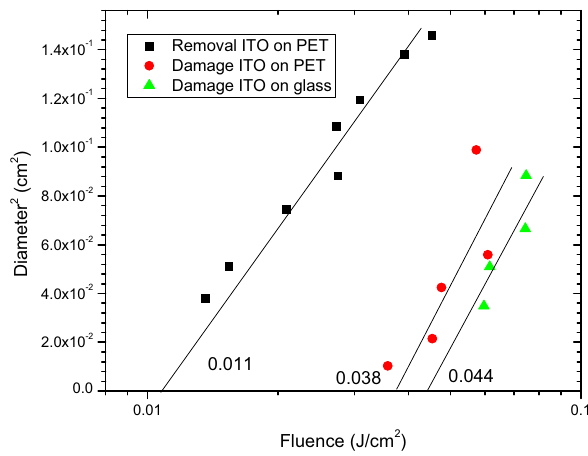
Figure 3: The threshold fl uence for ITO on glass and ITO on PET by 266 nm, ns laser.